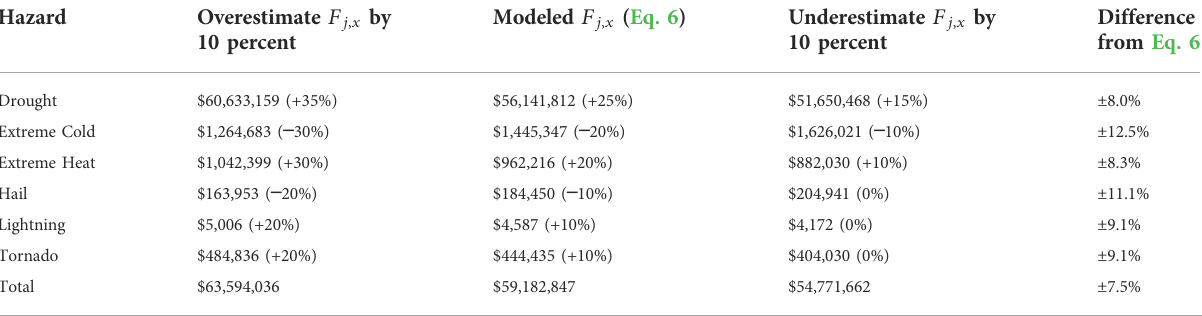
TABLE 10Sensitivityanalysis of annual crop loss (i.e., risk) estimates statewidein Louisiana for each hazard by 2050, for 10percentoverestimation or underestimation of the hazard intensity change (2019$). Hazard Overestimate F j,x by Modeled F j,x (Eq. 10 percent